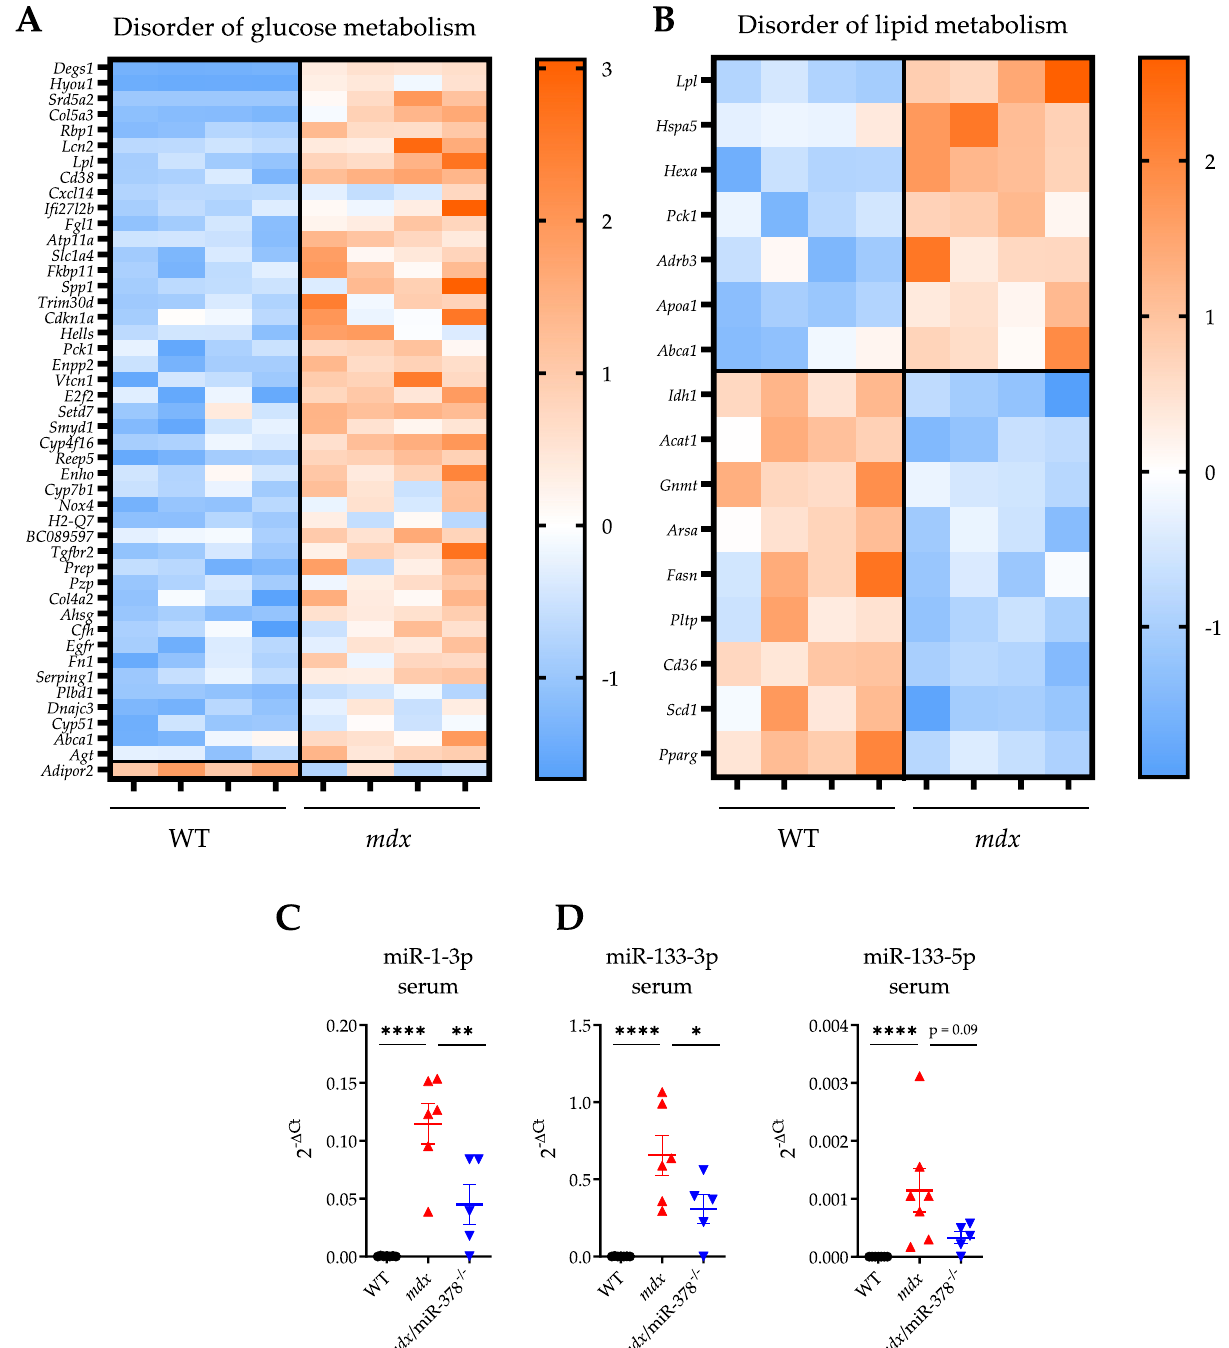
Figure 4. Disorder of glucose and lipid metabolism in the mdx mice is accompanied by higher expression of miR-1 and miR-133, further diminished as the result of the miR-378 loss. ( A , B ) Heat maps were created based on the list of genes indicated by ingenuity pathway analysis (IPA) that were attributed to the disorder of glucose ( p -value = 1.04 × 10 –12 ) and lipid metabolism ( p -value = 1.31 × 10 –6 ) in the liver of mdx mice. Blue color indicates downregulation, whereas orange upregulation. The expression of ( C ) miR-1-3p, ( D ) miR-133-3p, and miR- 133-5p in the serum as assessed by locked nucleic acid (LNA) technology; n = 5–7/group. Data are presented as mean ± SEM. * p < 0.05; ** p < 0.01; **** p < 0.0001 by one-way ANOVA with Tukey’s post-hoc